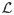
Spectrum of the Fokker-Planck operator L and related quantities.A: regular eigenvalues of L (blue) and diffusive ones (red) with real and imaginary part (top and bottom, respectively) as a function of the mean input μ for small noise intensity σ (left) and larger input fluctuations (right). The first two dominant eigenvalues λ1, λ2 are indicated together with discontinuities in the real (λ2) and imaginary part (λ1 and λ2), respectively. The stationary eigenvalue λ0 = 0 is shown in gray. Note that the value of the mean input μ at which the eigenvalue λn changes from real to complex values depends on the noise amplitude σ and the eigenvalue index n which is difficult to see in the figure. The narrow winding curves attached to the left side of the respective spectra represent the lower bound flux q(Vlb) for μmin = −1.5 mV/ms as a function of (real) eigenvalue candidate λ. The flux axis has a logarithmic scale between the large ticks (absolute values between 10−10 and 10−2 kHz) and is linear around the dashed zero value. The open circles denote the eigenvalues, i.e., those λ that satisfy q(Vlb) = 0. Note that q(Vlb) ranges over several orders of magnitude. B: stationary eigenfunction ϕ0 = p∞ (gray) and nonstationary eigenfunctions ϕ1 of L and ψ1 of L* corresponding to the first dominant eigenvalue λ1 for three different input parameter values indicated by the triangle and circles in A (same units of μ and σ as therein). The eigenfunctions are biorthonormalized, but (only) for visualization truncated at V = −100 mV and furthermore individually scaled to absolutely range within the unit interval of arbitrary units [a.u.]. C: first and second dominant eigenvalues λ1, λ2 with real and imaginary part (that are also indicated in A), as well as additional (real-valued) quantities of the model spec2 (M, S, Fμ, Fσ2) as a function of input mean μ and noise strength σ in steps of 0.2mV/ms from small values (black) to larger ones (green). The dots indicate identical parameter values to the spectra of A and the eigenfunctions of B (darker: σ=1.5mV/ms, brighter green: σ=3.5mV/ms).